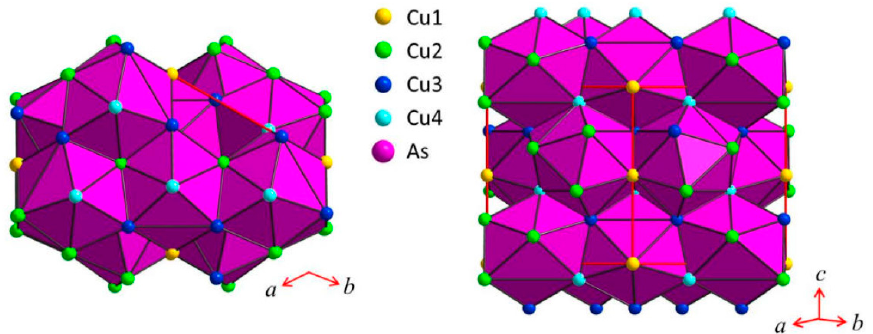
Figure 7. Sketch of the crystal structure of Cu 3 As where the coordination polyhedra around As atoms, As@Cu 11 , are highlighted. Table 4. Interatomic distances corresponding to the first coordination sphere for d obs / Σ r M ≤ 1.16 in Cu 2.882(1) As, as obtained from single crystal analysis.